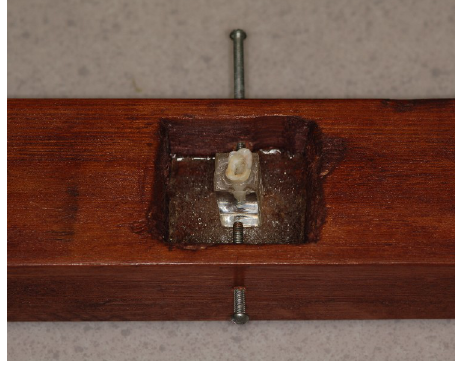
Figure 2 : Acrylic-resin block positioned for